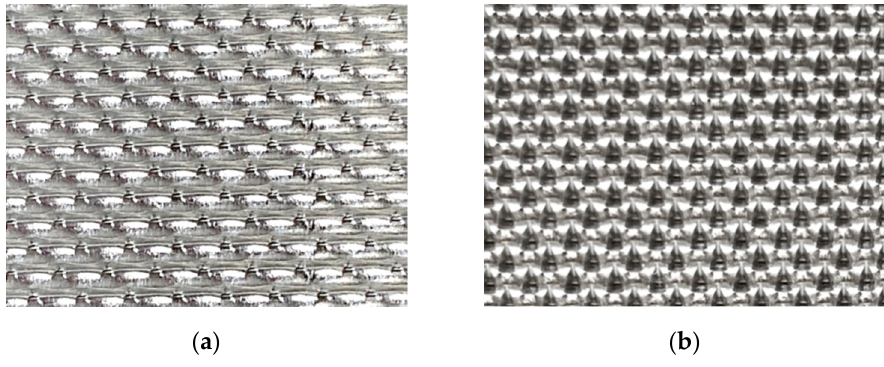
Figure 1. Picture of the MEMM: ( a ) Small side; ( b ) Large side.